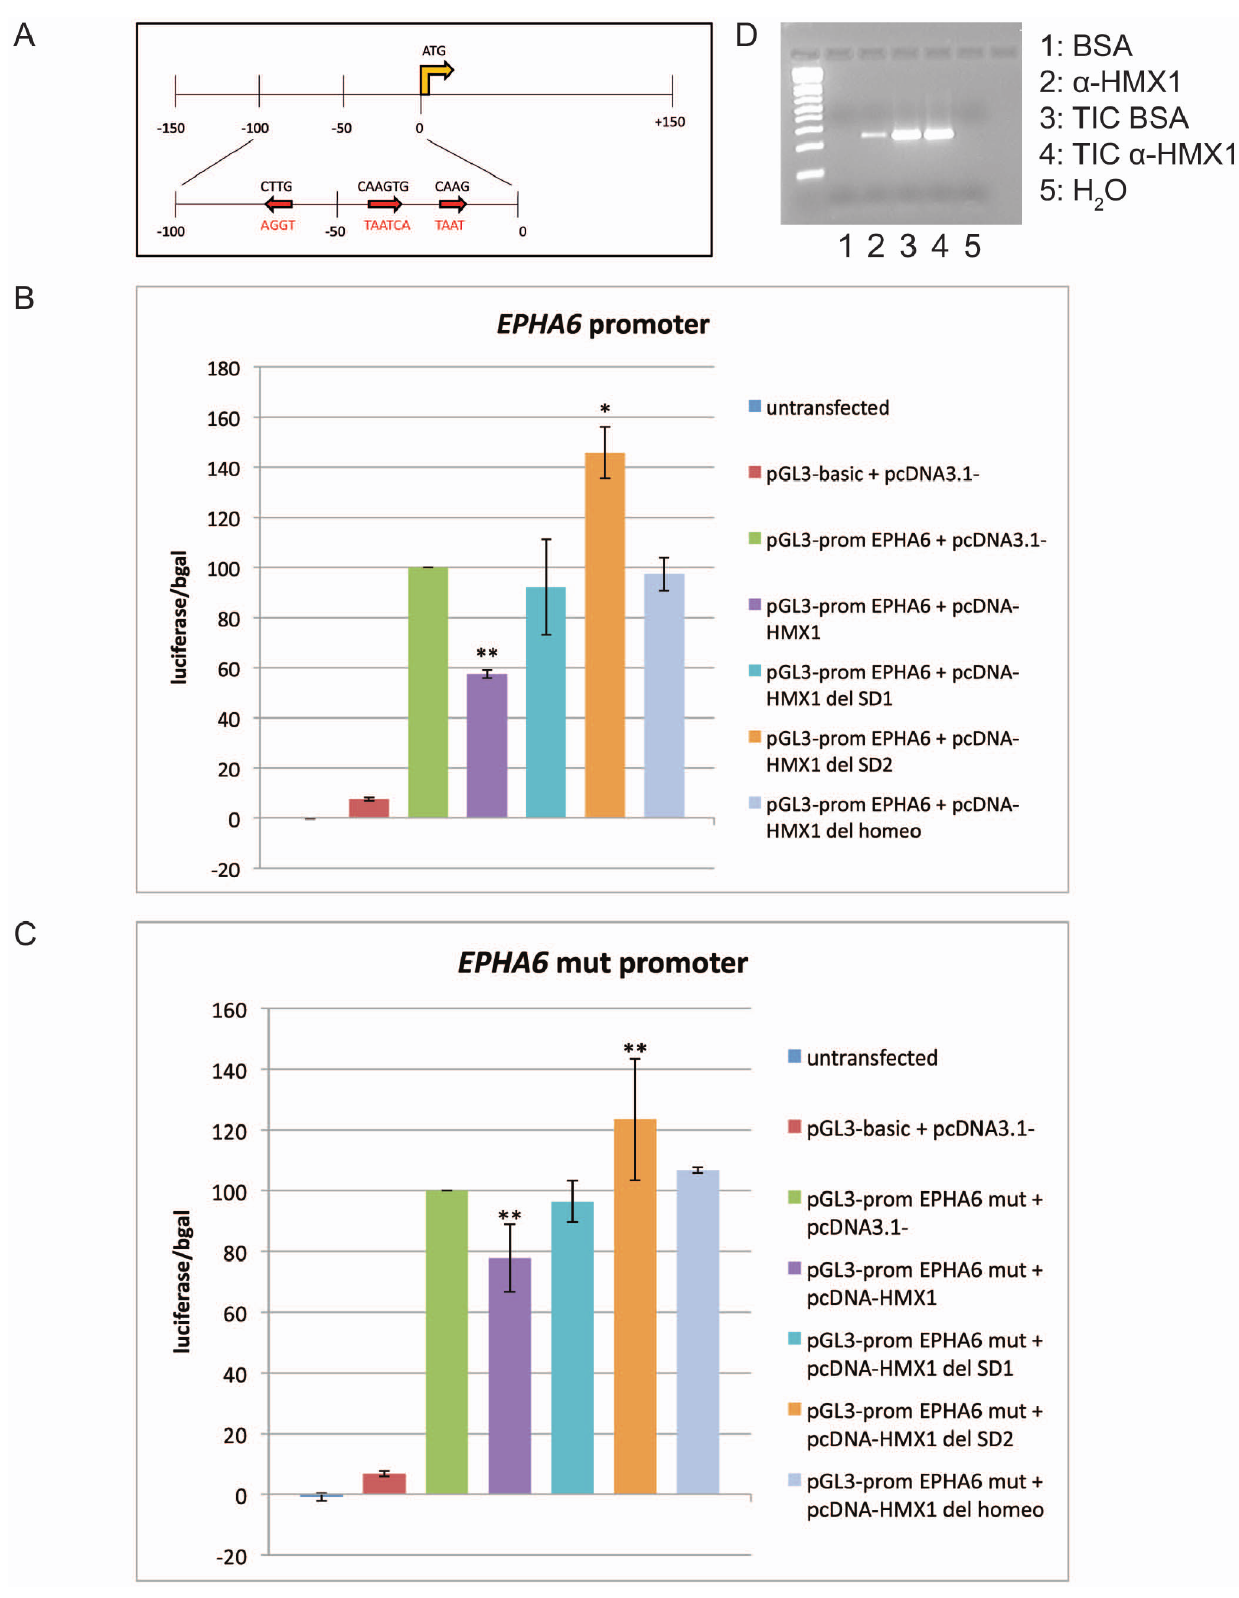
Figure 5. Action of HMX1 on the EPHA6 promoter. Schematic representation of the subcloned fragment of the EPHA6 promoter with the three binding sites (red arrows and black characters), and the mutated sequences (red characters) (A). Luciferase assay on the wt EPHA6 promoter with HMX1, HMX1 del SD1, HMX1 del SD2 and HMX1 del HD. HMX1 inhibits the promoter by 42%, HMX1 del SD1 and HMX1 del HD have no effect, and